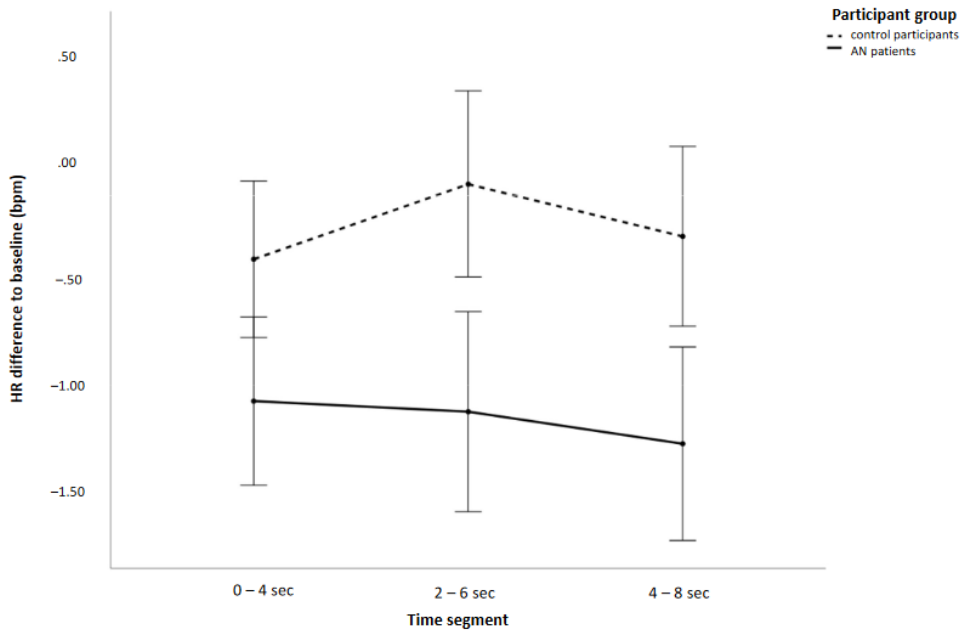
Figure 2. HR difference scores (bpm = beats per minute) across all picture categories for the 3 time segments and patient and control participants separately.